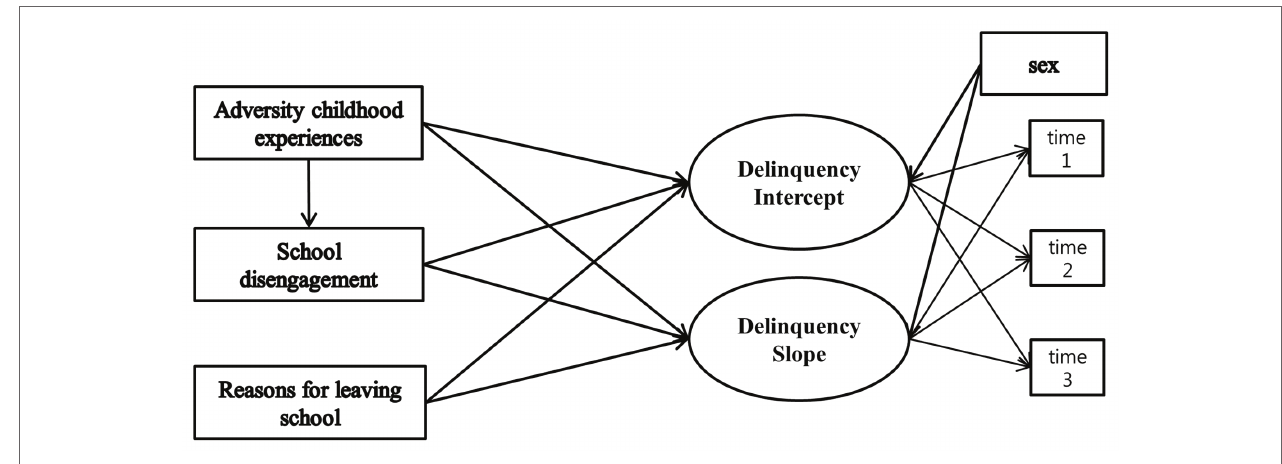
FIGURE 1 | Multivariate latent growth